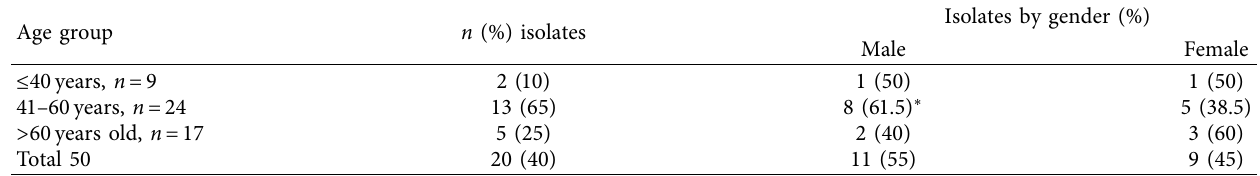
Figure 2: Real-time PCR detection of A. baumannii . Te black arrow represents the positive control, the orange arrow represents the samples, and the red arrow represents the negative control. Table 2: Distribution of A. baumannii between age groups and